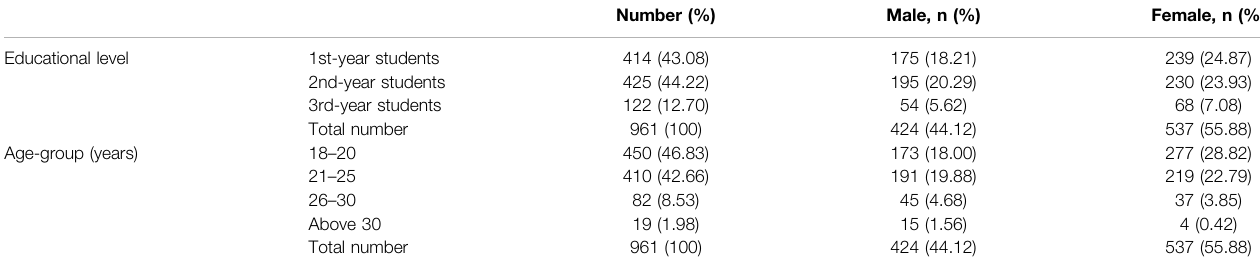
TABLE 2 | Sociodemographic characteristics of